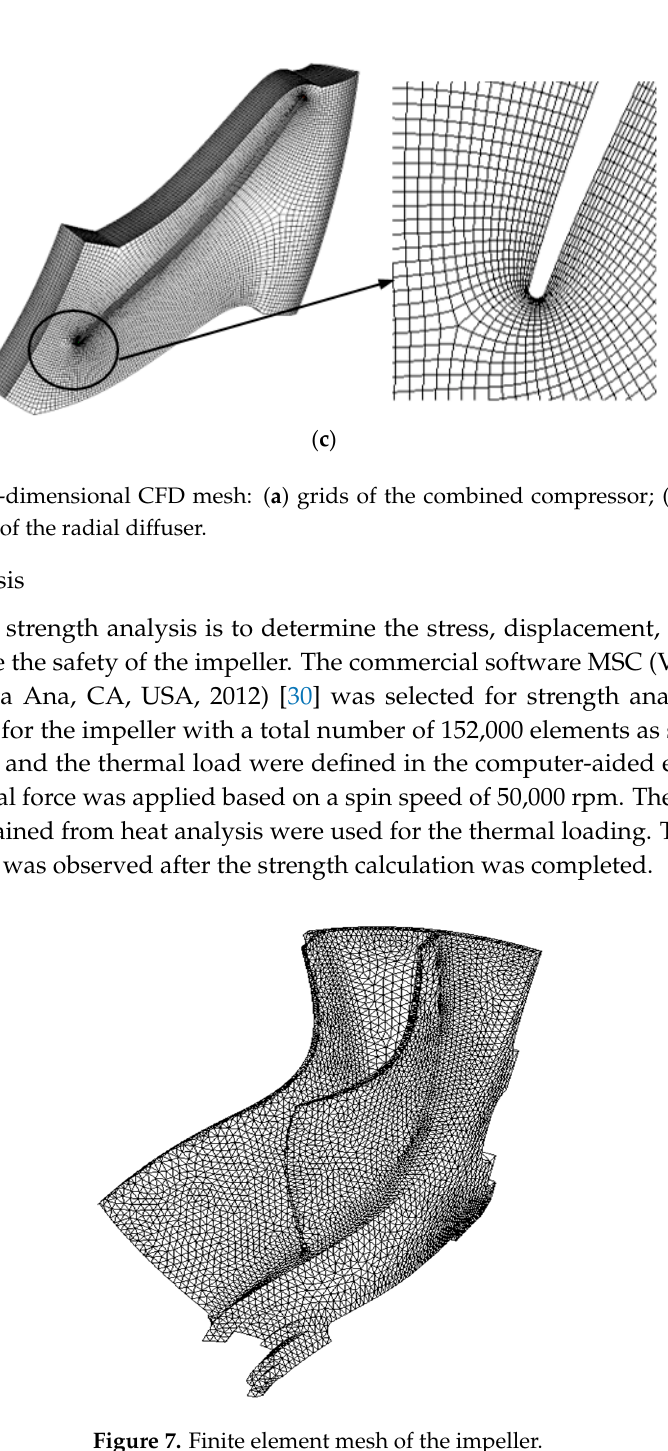
Figure 7. Finite element mesh of the impeller.